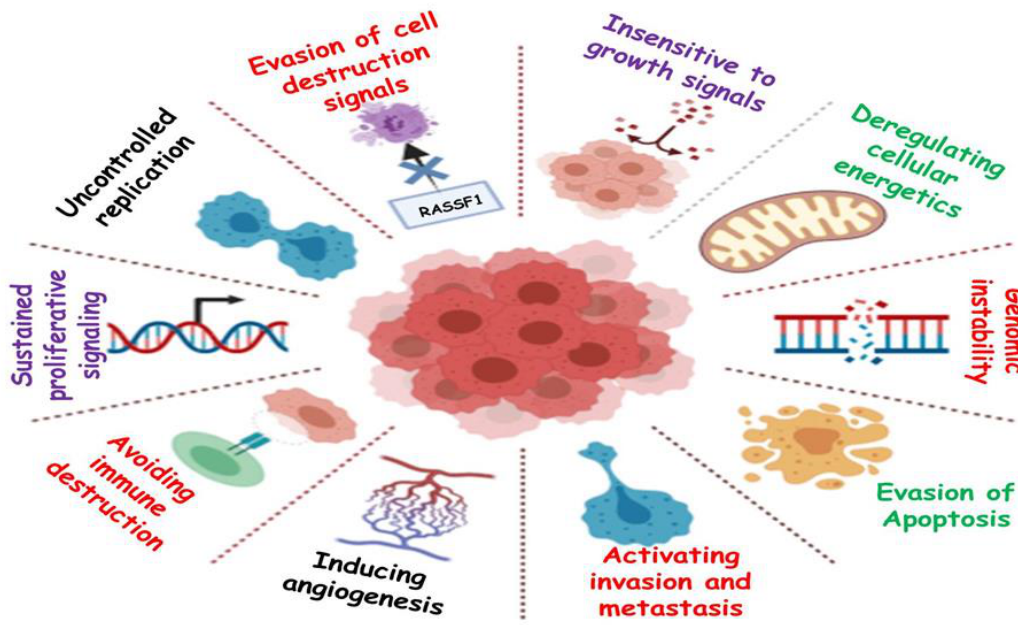
Figure 1. Graphical representation of the hallmarks of cancer.